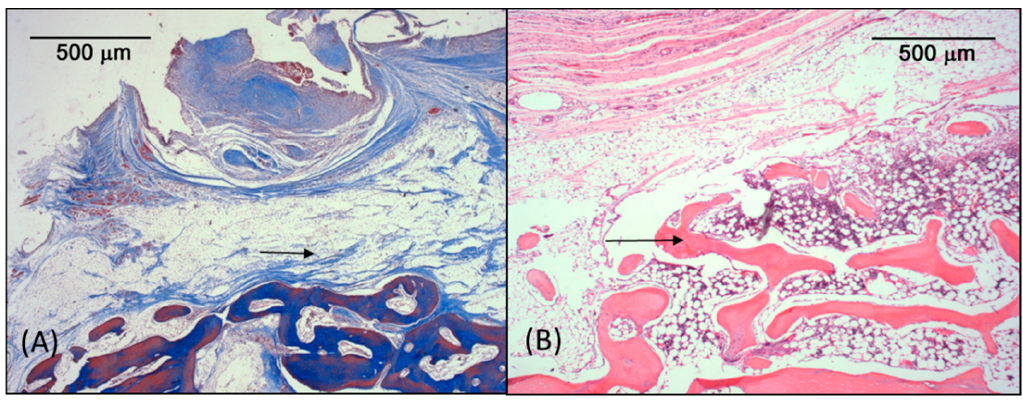
Figure 8. Microscopic images from Group 3: ( A ) Connective tissue around adipose islands (black arrow). ( B ) Bone tissue present in some samples.